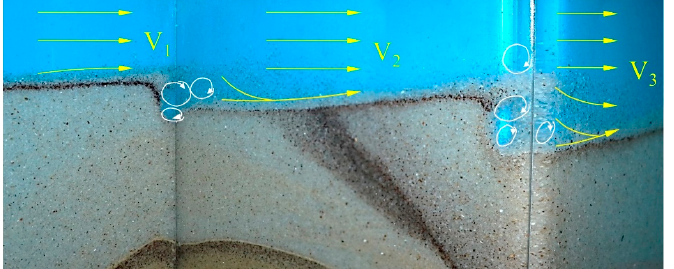
Figure 6. Vortices of 40/70 mesh sands around two bends, enlarged view of the deviated section in Figure 5c. Figure